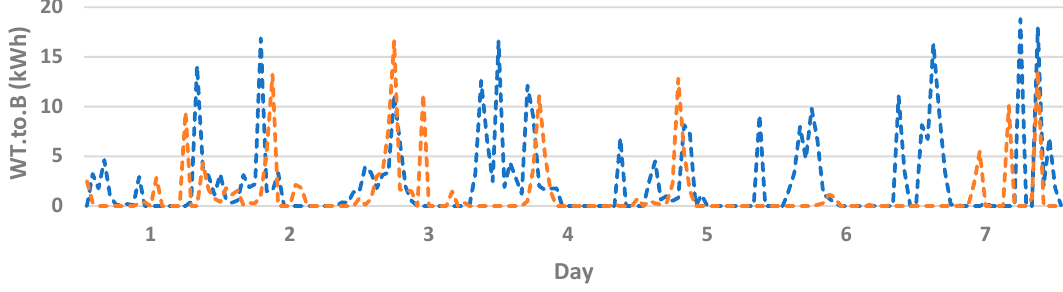
Figure 9. Energy transmission from PV panels to the battery bank, for a single dwelling. Comparison between the most and least probable scenarios (blue and orange) for one week of April. Source: self- elaboration.